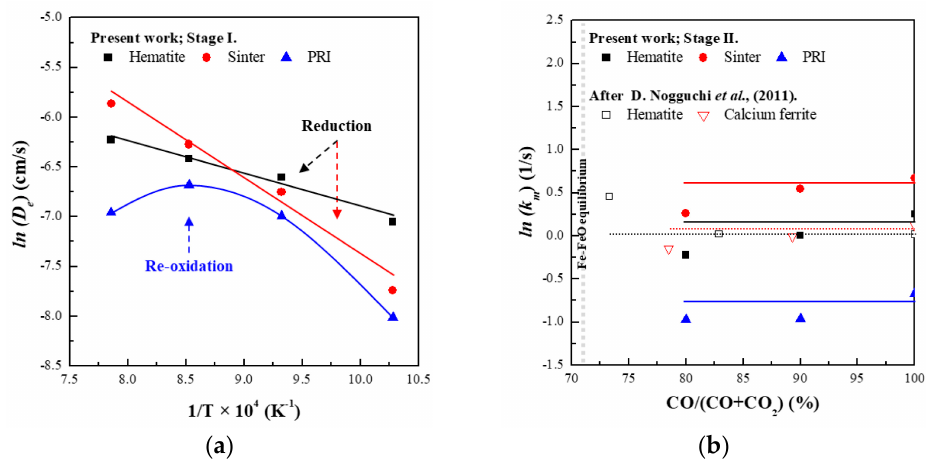
Figure 6. Changes in ( a ) effective diffusivity in Stage I and ( b ) mixed controlled rate constant in Stage II.